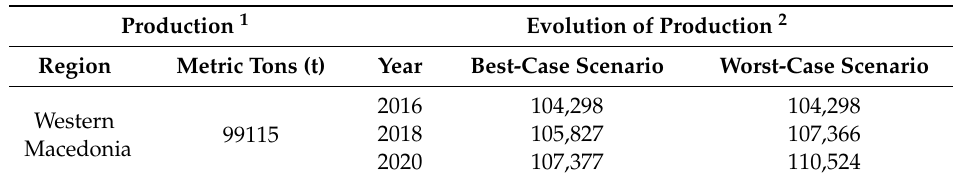
Table 2. MSW production, projection and composition * in Western Macedonia region (data for 2015) (data compiled and derived from [30]).